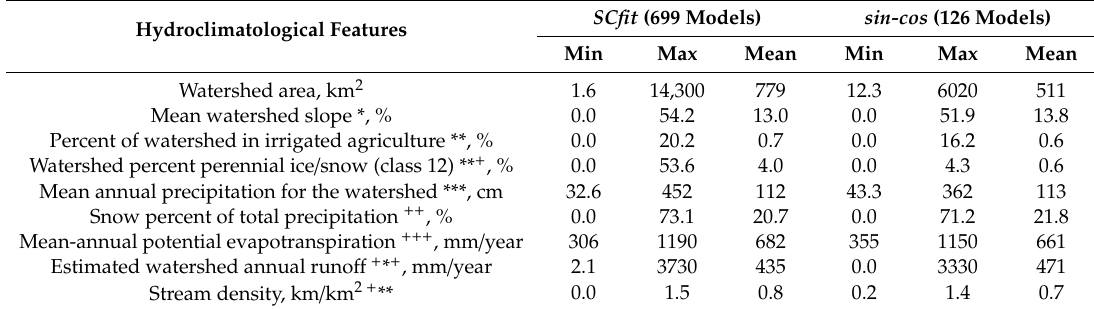
Table 3. Minimum, maximum, and mean values for landscape and hydro-climatological features for accepted